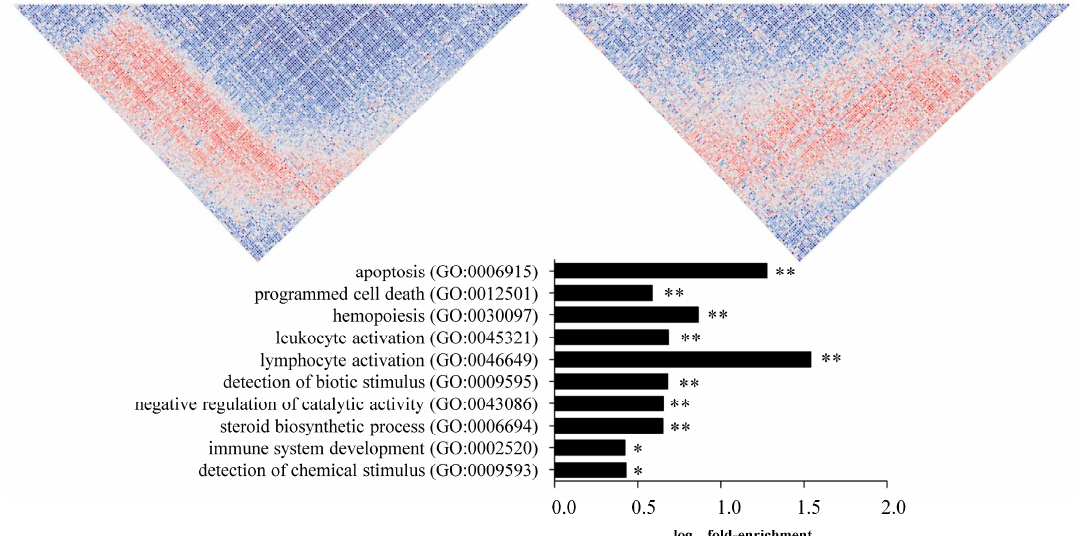
Figure 2. Co-expression and Gene Ontology (GO) annotation studies in DCGs. Co-expression pattern changes of DCGs with enrichment for CAMP Responsive Element Binding Protein 1 (CREB1), ETS domain-containing protein (ELK1) and homeobox protein Hox-A5 (HOXA5) binding sites, from treated celiac disease (CD) to active CD (chronic experiment). Each small square represents the P -value of the correlation between the expression levels of a specific gene pair (red-blue scale represents positive to negative Spearman correlation). Below, the top 10 GO annotations for those DCGs compared to the whole-genome. GO terms are indicated in the Y axis. The X axis shows the log 10 fold-enrichment (ratio between the percentage of genes annotated with the GO term in the test set and the number of genes annotated with such term in the whole-genome (*** p < 0.001, ** p < 0.01 and * p < 0.05)).